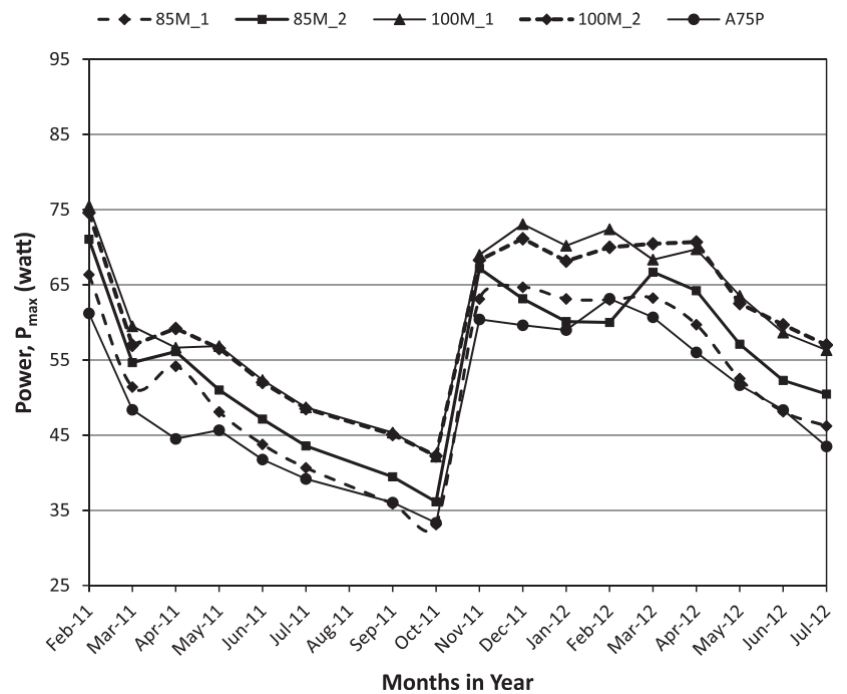
Figure 12. Daily peak power output (monthly averaged). Reprinted from Renewable Energy, 60, Adinoyi M. et al., Effect of dust accumulation on the power outputs of solar photovoltaic modules, 634., Copyright (2013), with permission from Elsevier[31].